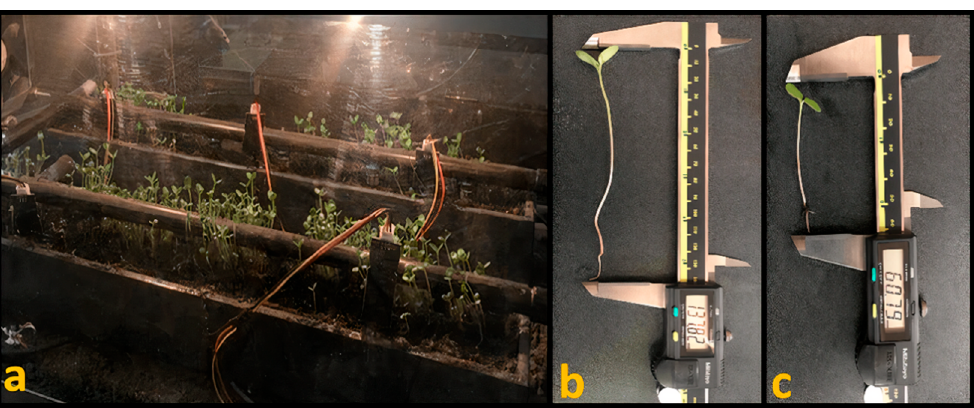
12 of 17 Figure 6. Simulation ( a ) and implementation ( b ) of soil moisture PID control. 3.2. Germination Parameters